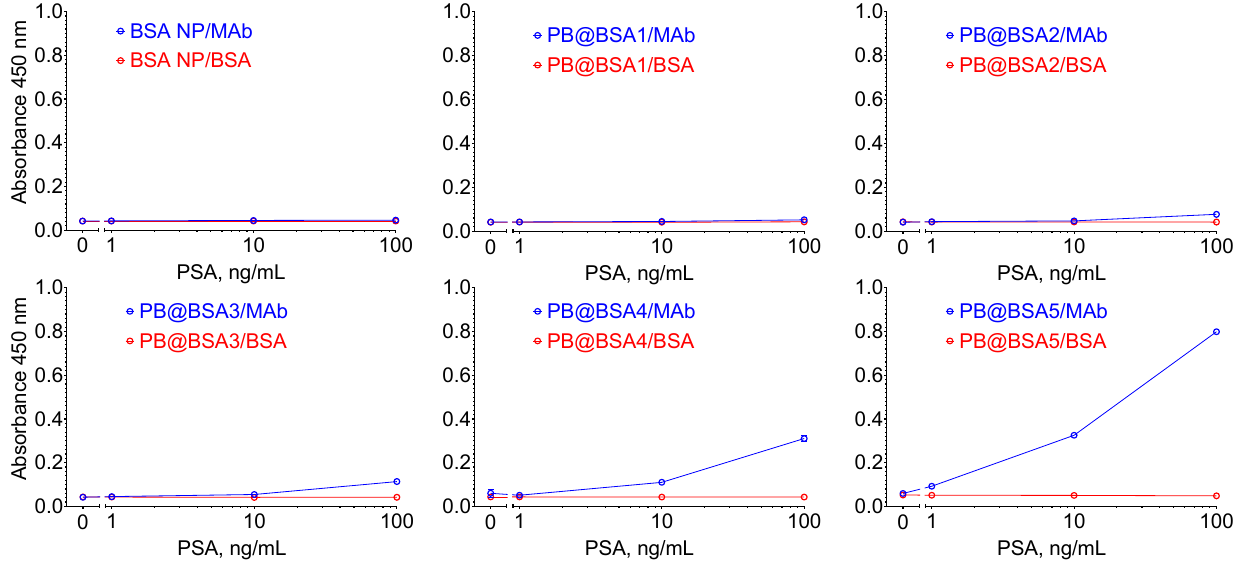
Figure 4. Calibration curves in PSA assay obtained for various PB@BSA nanoparticles conjugated with anti-PSA MAbs or BSA. Concentration of nanoparticles—0.1 mg/mL. Means ± SDs of 3 technical replicates are presented. Error bars are very small and hidden by the data points.